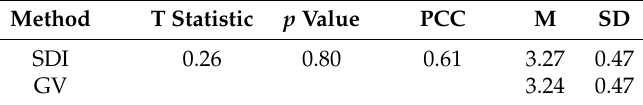
Table 5. SDI Validation Result Using the Gradient